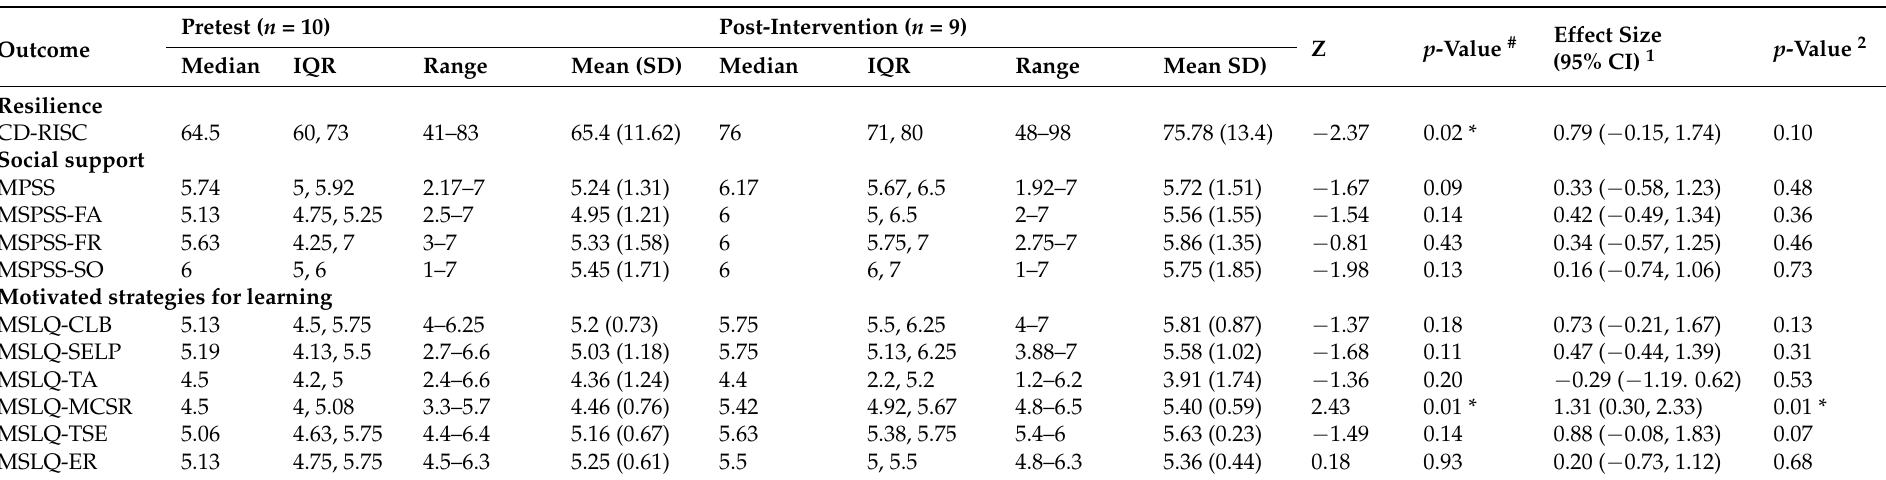
Table 4. Effects of the RISE program on the students’ resilience, social support, and learning